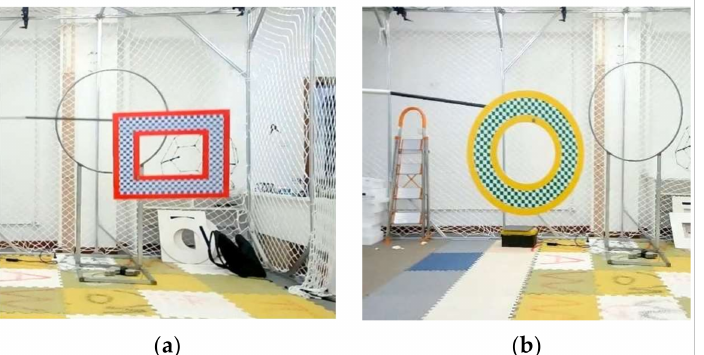
Figure 13. The type of testing targets: ( a ) rectangle target with grid pattern; ( b ) circular target with grid pattern. The size of various targets is about 40 cm.